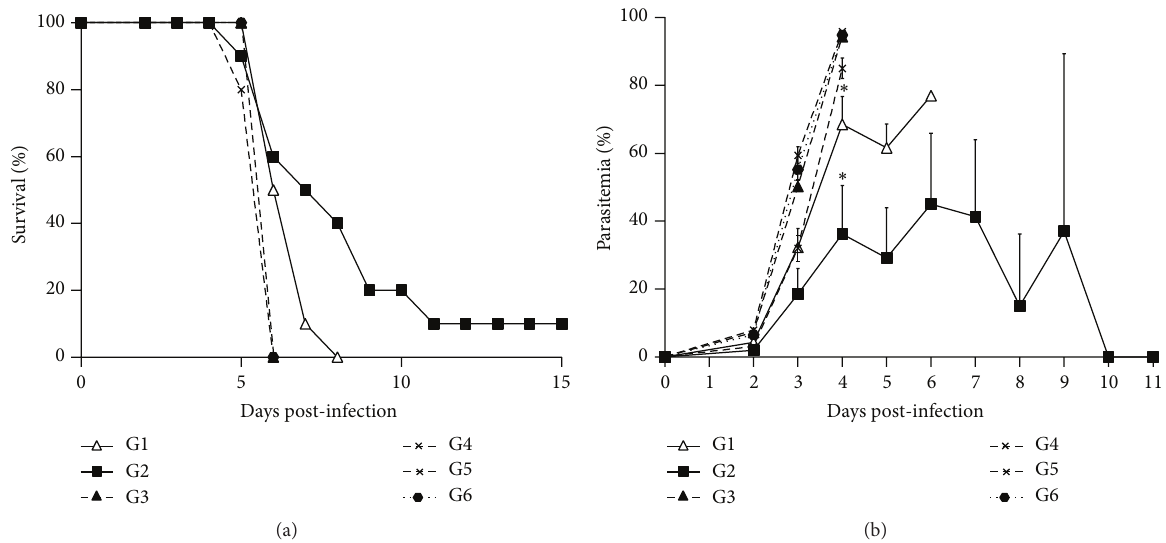
Figure 3: Course of infection after vaccination with different adjuvants in BALB/c mice. Mice were divided into 6 groups ( 𝑛 = 10 each) to be immunized on days 1 and 27. Group (G) 1 with 2 𝜇 g of purified antigens and CpG ODN 1826 plus IFA, G2 with 2 𝜇 g antigens plus CFA, G3 with 2 𝜇 g of antigens, G4 with PBS and CpG ODN 1826 plus IFA, G5 with PBS and CFA, and G6 with PBS. On day 27 CFA was replaced with IFA. At day 55, all mice were challenged with 2 × 10 7 PyL- RBCs. Percentages of (a) survival and (b) parasitemia are shown as mean ( ± SEM). ∗ 𝑃 < 0.05 comparing to controls with antigens or same adjuvant alone or PBS (G2 versus G3, G5, and G6; G1 versus G3, G4, and G6).